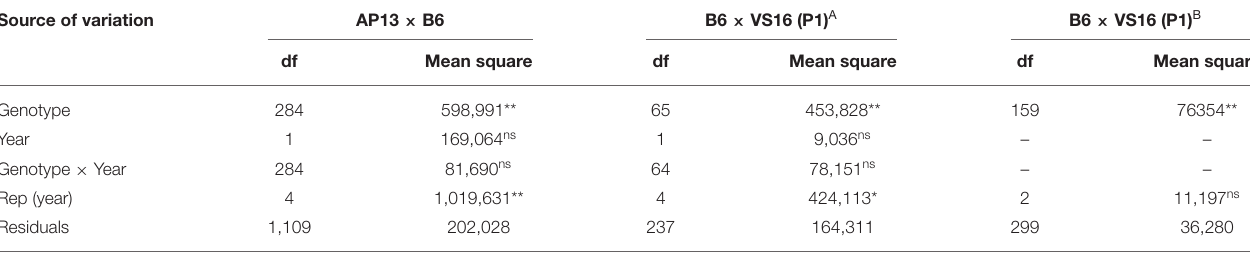
TABLE 3 | Analysis of variance of biomass weight in both populations evaluated in 2018 and 2019. Source of